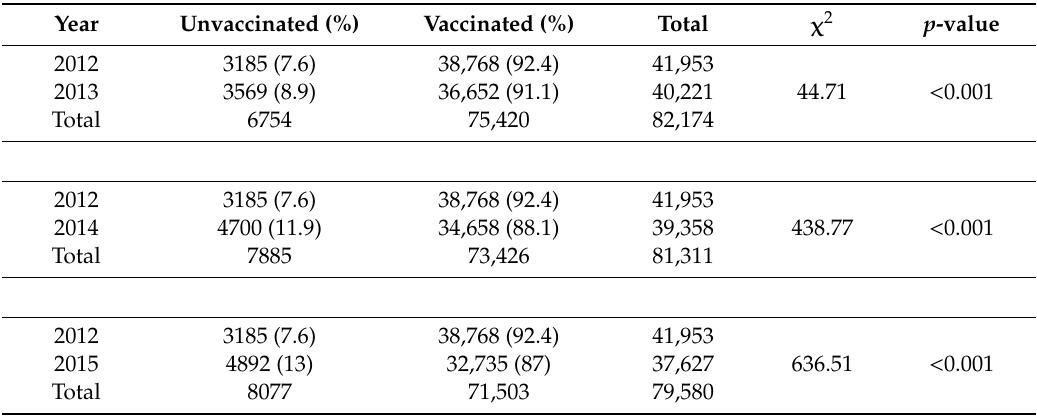
Table 3. Percentage of vaccinated and unvaccinated children in the Emilia-Romagna region in 2012 and comparisons with the following